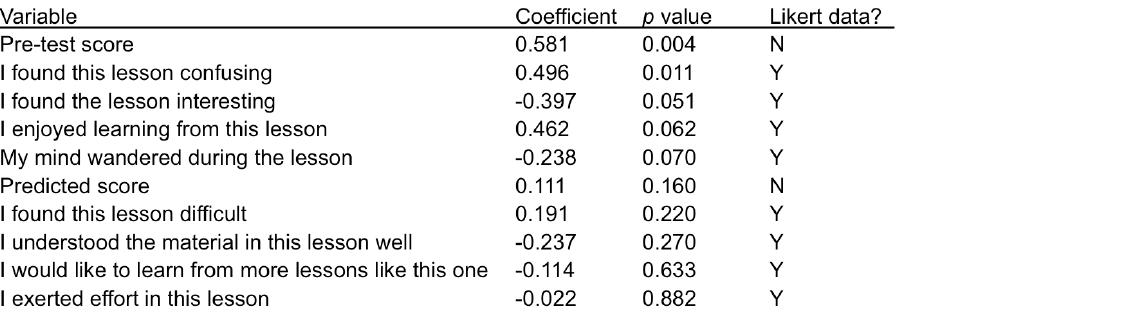
Predicting Post-Test Scores with Ordinal Logistic